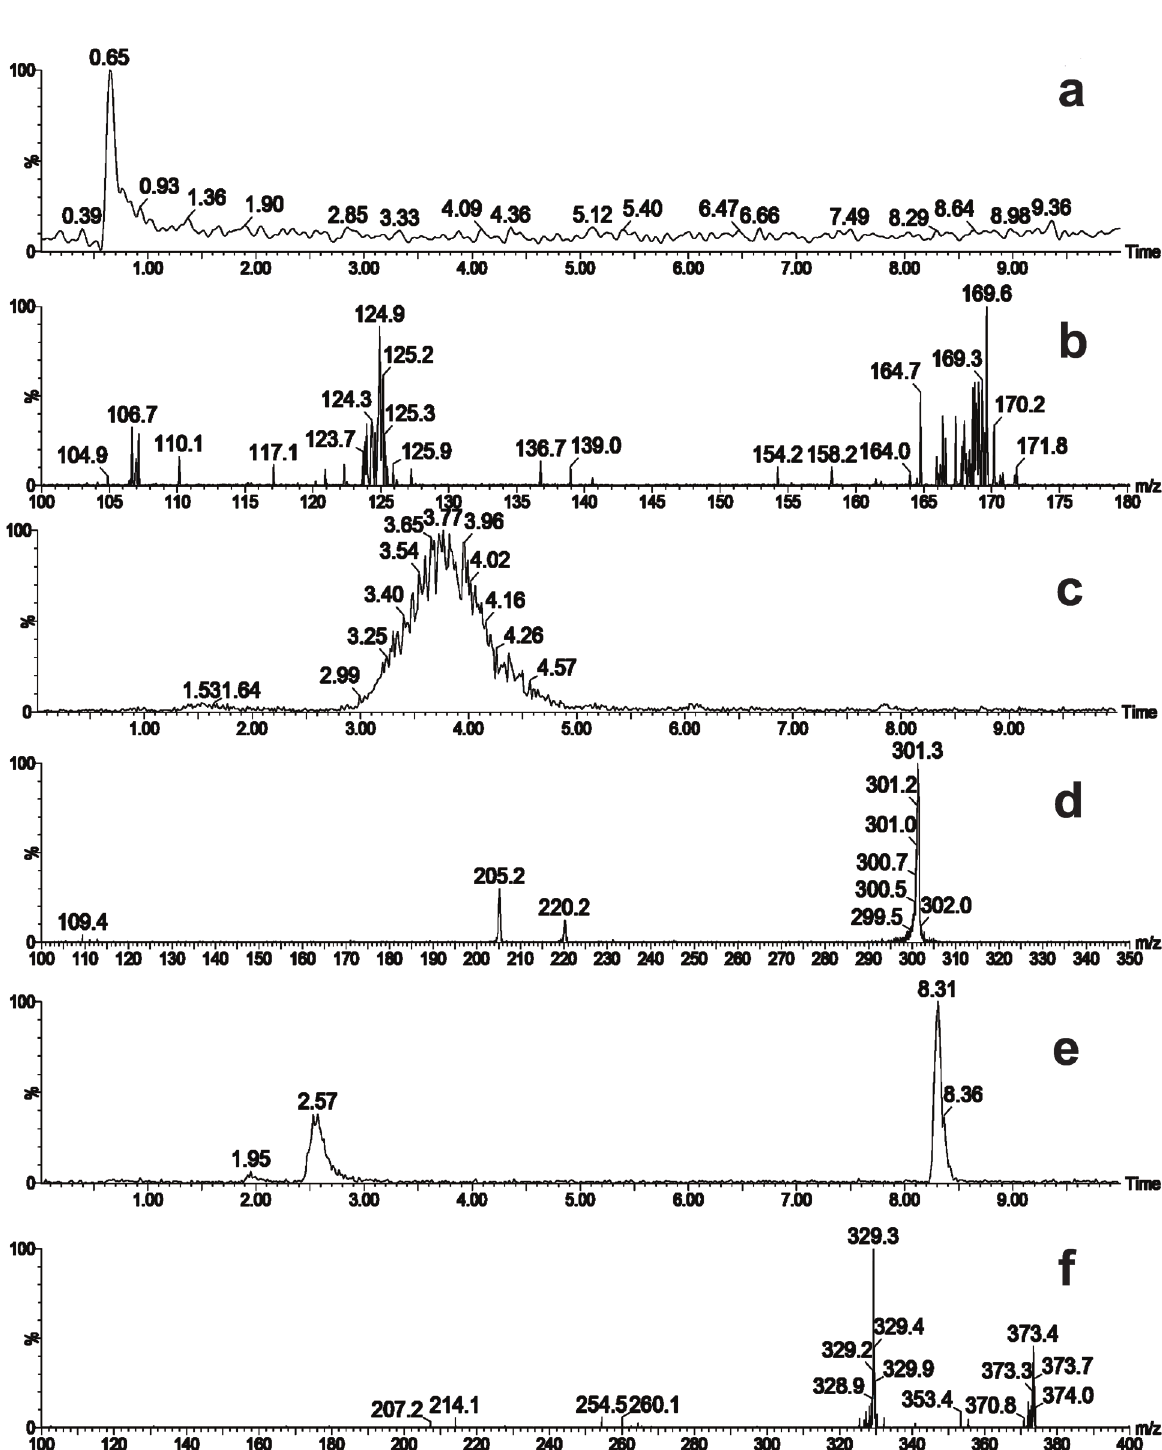
Figure 2 - Extracted ion UHPLC-MS chromatograms for ( a ) m/z 169, ( c ) m/z 301, and (e) m/z 373. MS/MS fragments for ions ( b ) m/z 169, (d) m/z 301, and ( f ) m/z